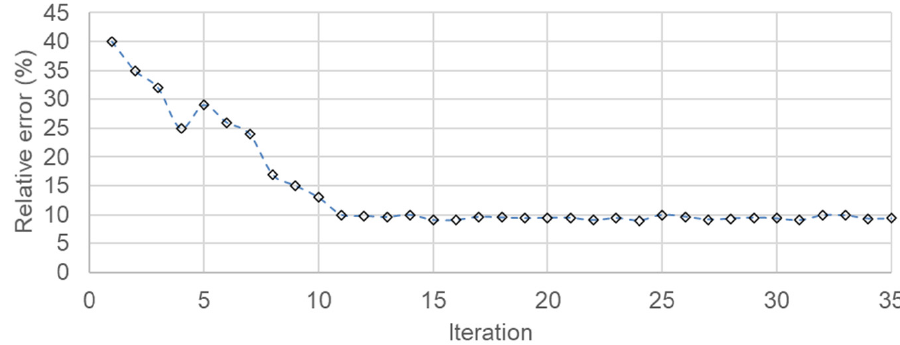
Figure 6. Convergence Curve of PSO algorithm.